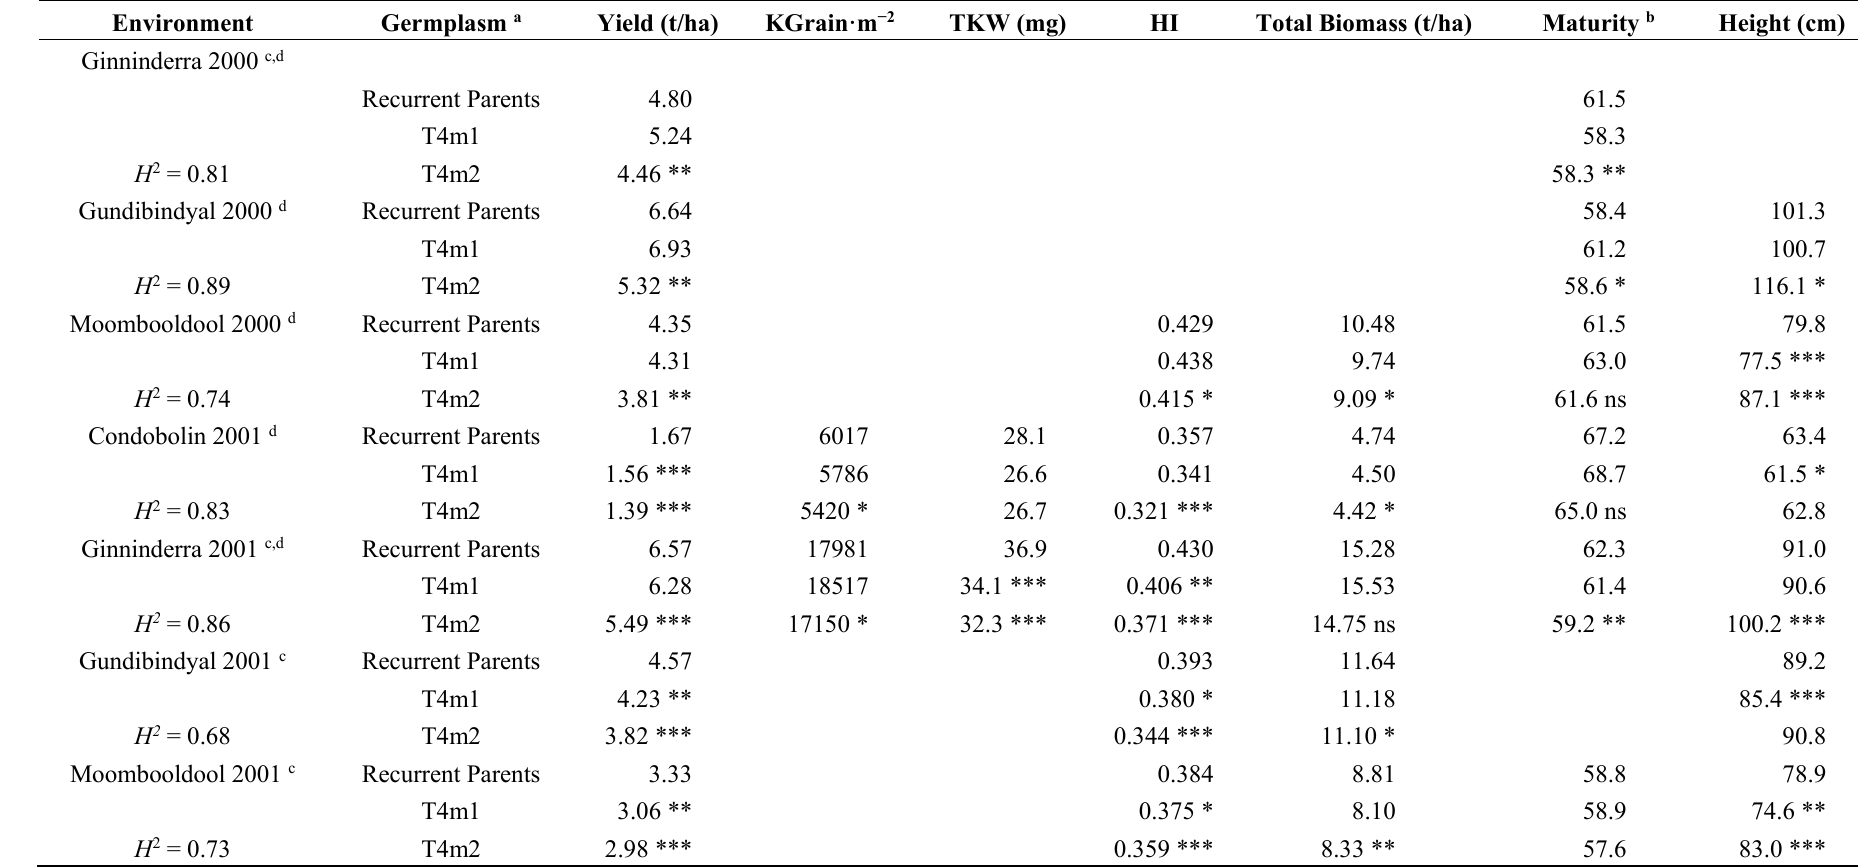
Table 2. Effects of T4 translocations on grain yield, yield components, maturity and